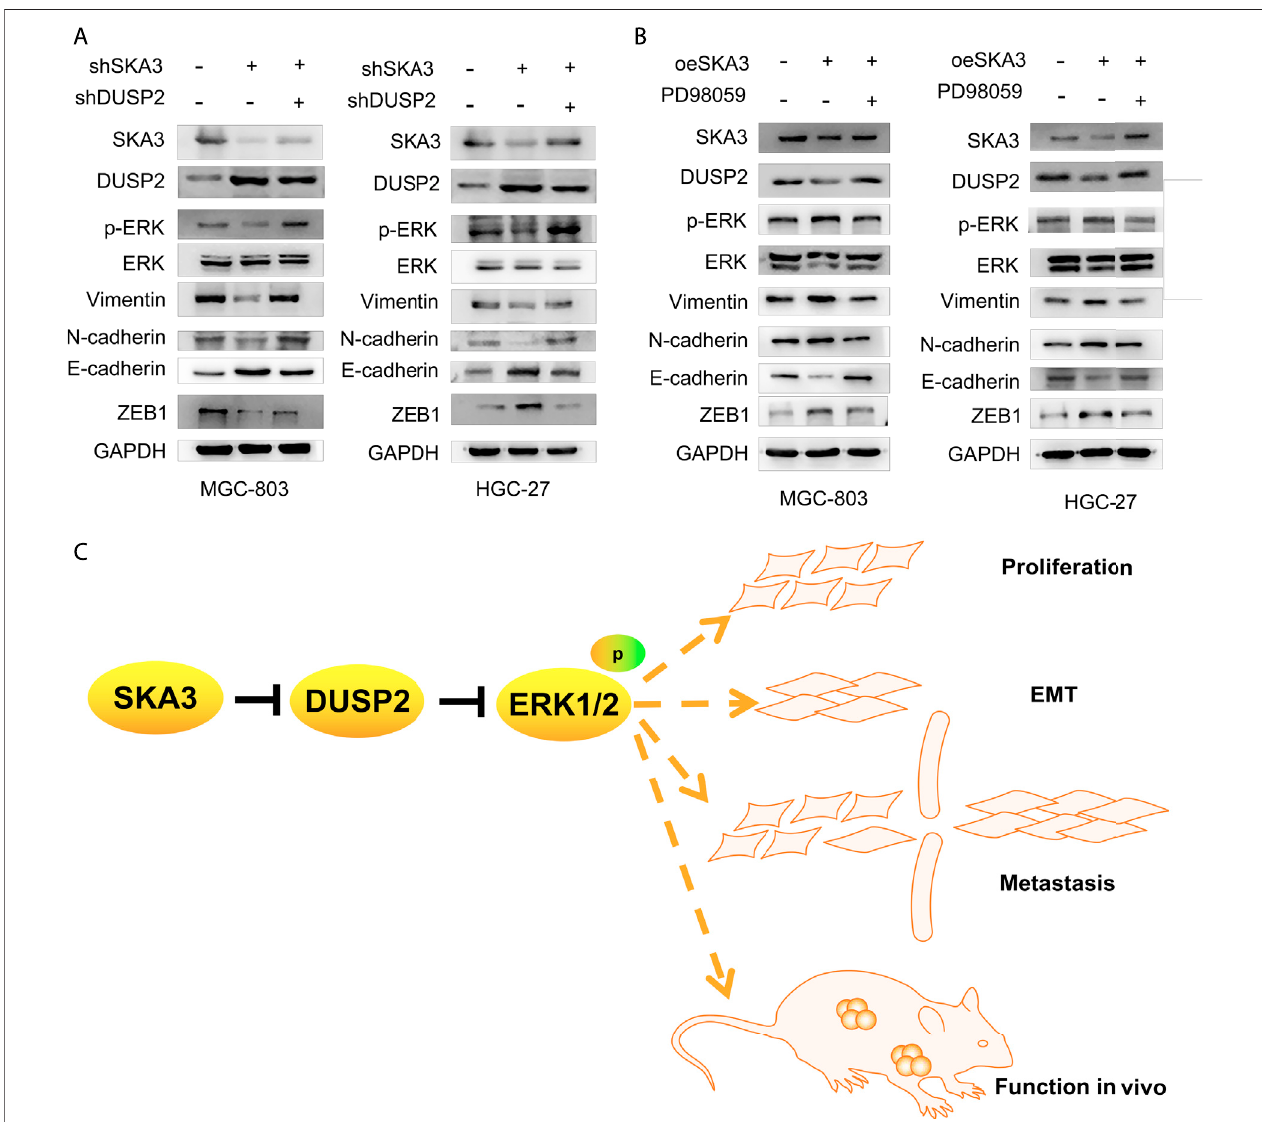
FIGURE 8| A model illustrating SKA3-DUSP2-ERK1/2axis in gastric cancer. (A) Co-transfected with shSKA3 and shDUSP2 rescue EMT and MAPK/ERK related proteins compared with shSKA3 group in MGC-803 and HGC-27. (B) Co-transfected with oeSKA3 and PD98059 rescue EMT and MAPK/ERK related proteins compared with oeSKA3 group in MGC-803 and HGC-27. (C) Model of SKA3-DUSP2-ERK1/2 axis in gastric cancer.